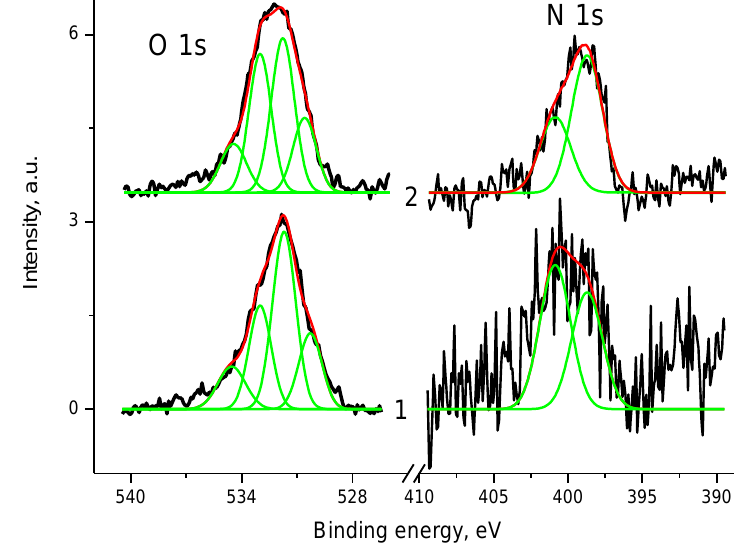
Figure 19. The O 1s and N 1s photoelectron spectra of samples 3 (1) and Pt/3 (2) (initial spectra – black, basic curves – green, resulting curves – red).